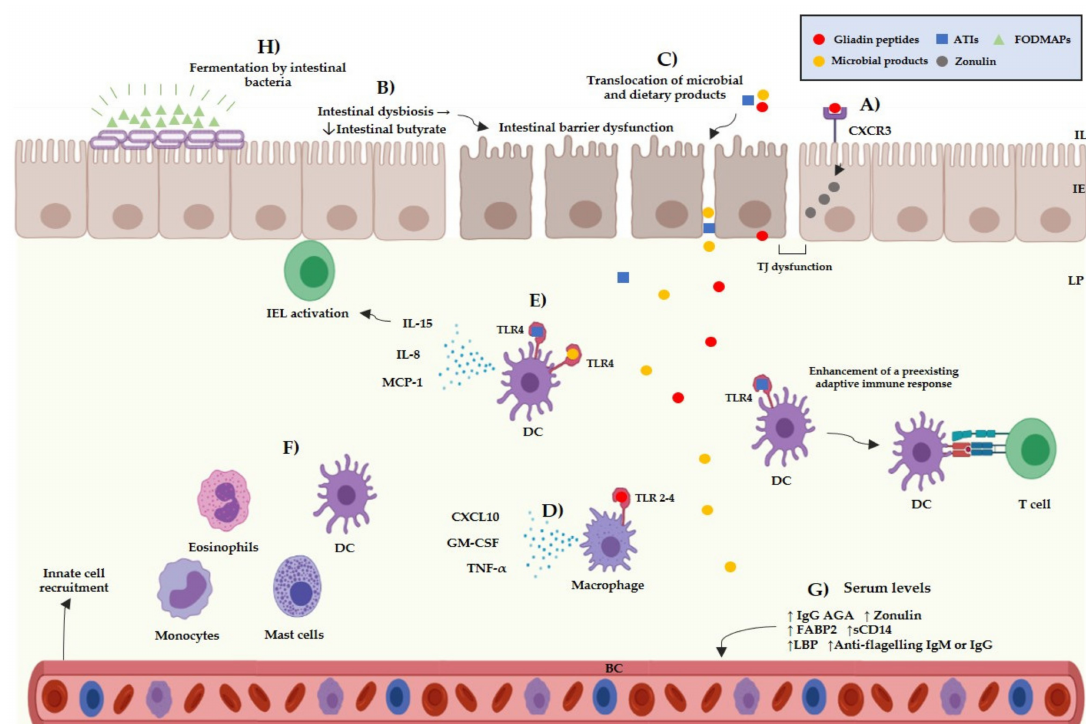
Figure 2. Current evidence of the potential pathogenic mechanism of NCGS. ( A ) Interactions between gliadin peptides and CXCR3 receptors in the intestinal epithelium trigger the release of zonulin increasing the intestinal permeability. ( B ) A chain of reactions that involves the decrease of intestinal butyrate, increased levels of FABP2 and low levels of intestinal alkaline phosphatase is induced by an intestinal dysbiosis, which can induce an intestinal barrier dysfunction. ( C ) Microbial and dietary products can reach the lamina propria from the intestinal lumen due to an increased intestinal permeability. ( D ) Interactions between gliadin peptides and toll-like receptors 2–4 can occur triggering the release pro-inflammatory cytokines, such as CXCL10, GM-CSF, and TNF- α by myeloid cells. ( E ) Interactions between the TLR4-MD2–CD14 complex and ATIs/LPS could trigger the release of pro-inflammatory cytokines, such as IL-8, MCP-1, and IL-15 by myeloid cells. ATIs can enhance the adaptive immune response in the gut associated lymphoid tissue inducing the antigen presentation to T cells. ( F ) The release of pro-inflammatory cytokines can promote the recruitment of myeloid cells in the lamina propria, such as mast cells, eosinophils, monocytes, and dendritic cells, triggering local inflammation. ( G ) Microbial products can reach the blood stream triggering a systemic immune response. ( H ) FODMAPs can be fermented by the intestinal bacteria, giving rise to intestinal luminal distention. IL: intestinal lumen, IE: intestinal epithelium, LP: lamina propria, BC: blood circulation, TJ: tight junction, ATIs: amylase and trypsin inhibitors, FODMAPs: fermentable oligo-, di-, monosaccharides, and polyols, IEL: intraepithelial lymphocytes, DC: dendritic cell, TNF- α : tumor necrosis factor α , MCP-1: monocyte chemoattractant protein-1, GM-CSF: granulocyte-macrophage colony-stimulating, AGA: anti-gliadin antibodies, FABP2: intestinal fatty acid-binding protein 2, LBS: lipopolysaccharide-binding